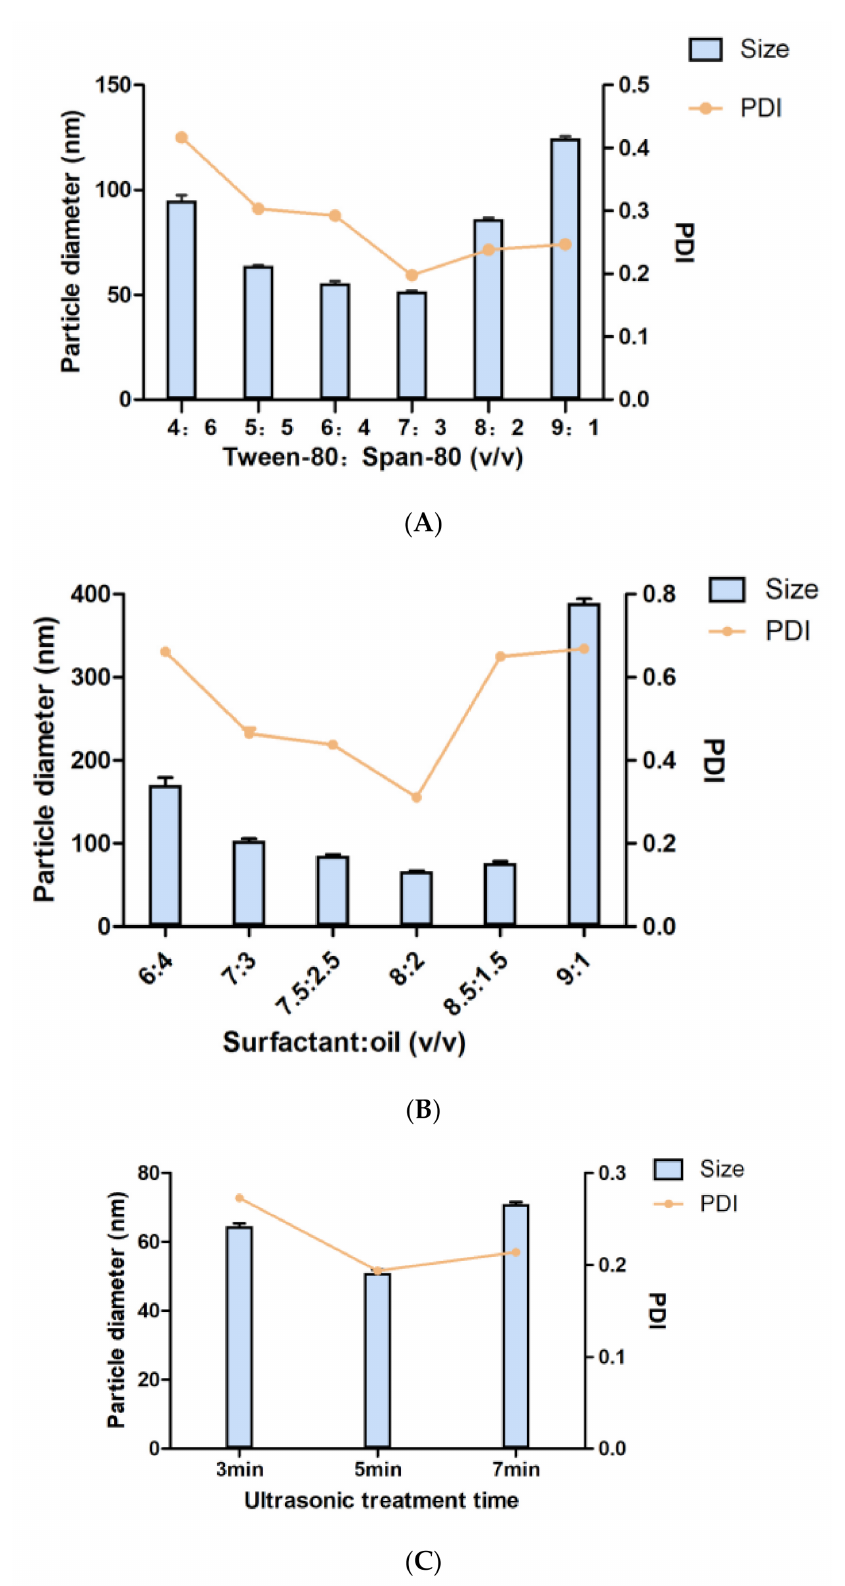
Figure 1. Influences of ratios of the Tween-80 to Span-80 ( A ), ratios of surfactants to Massoia lactone (oil) ( B ) and ultrasonic treatment time ( C ) on the particle size and PDI of the formed NEs. Data are given as mean ± SD, n =